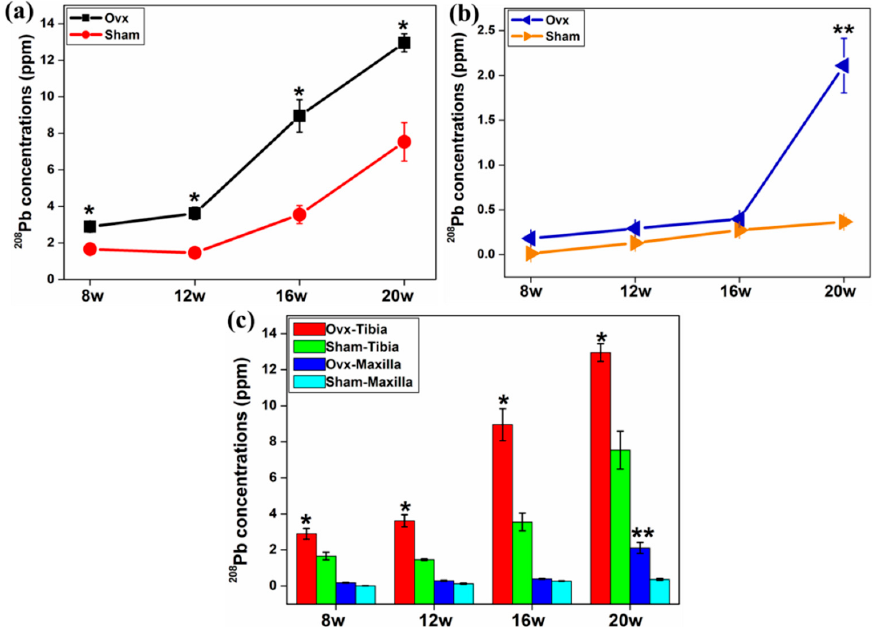
Figure 2. Ovx increased the average concentrations of 208 Pb (normalised against matrix-matched reference materials) for both tibia ( a ) and maxilla ( b ) at all time points post-surgery, compared to the sham group; and ( c ) tibial bone accumulated more 208 Pb compared to maxillary bone. *: Significant difference ( p < 0.05) between Ovx-tibia and Sham-tibia; **: Significant difference ( p < 0.05) between Ovx-maxilla and Sham-maxilla.